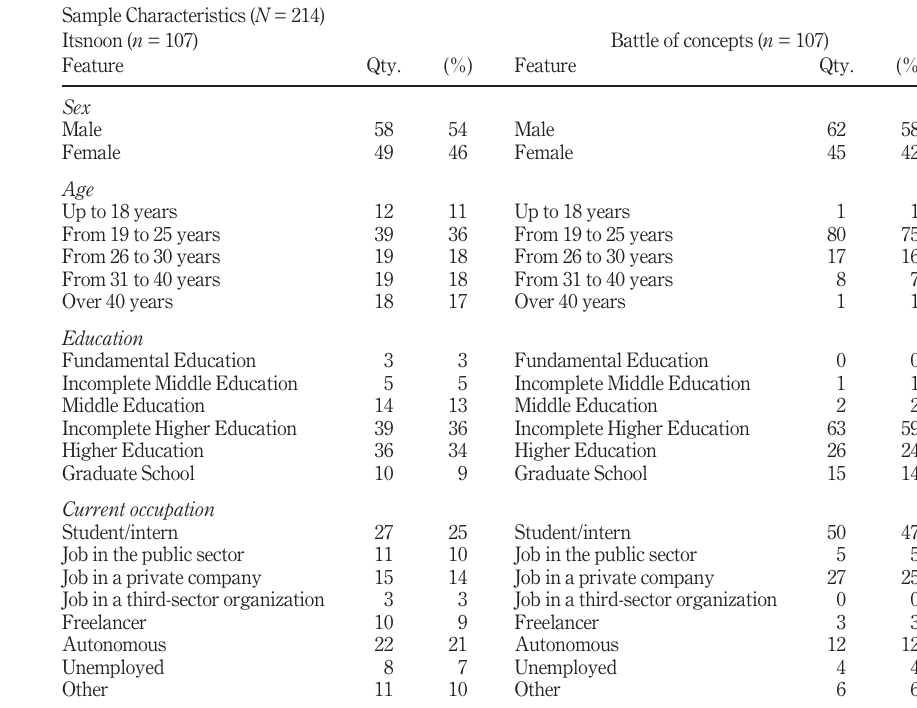
characteristics